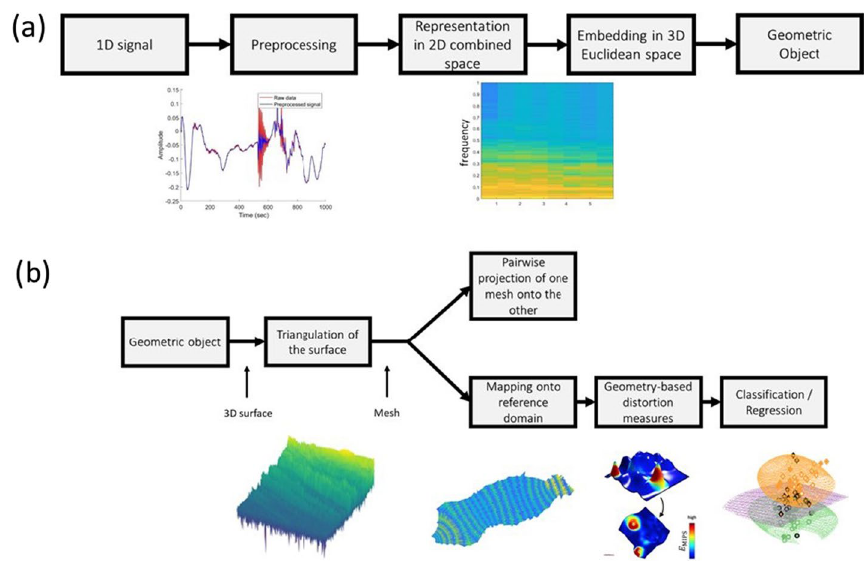
Fig. 1 High-level schematic overview of the proposed model. a Highlights the ‘embedding’ process. Subsequent to the preprocessing, the spectrogram of the 1D signal is computed and presented as a surface. This allows the conversion of the original problem of 1D signal analysis to geometric analysis of manifolds. The second part of the proposed method begins with this ‘geometric object,’ which is the output of the first part. b Summarizes how this geometric object is used for the extraction of features. First, the spectrogram is converted to a mesh, by means of the Delaunay algorithm. Then, the meshes are projected into a target domain by using the ABCD algorithm. The meshes are clustered in this target domain, with reference to a well-defined metric. Finally, distortions measures are computed from the obtained